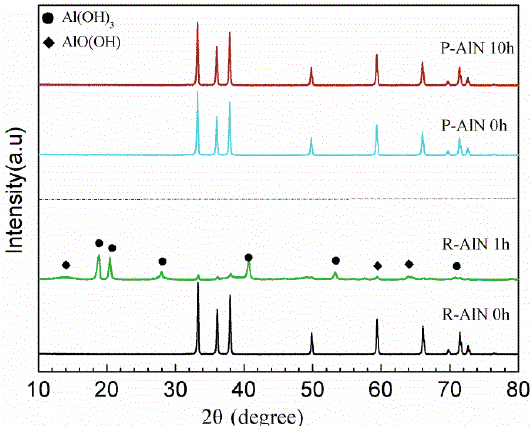
Figure 7. XRD spectrum of raw powder and modified powder under different hydrolysis resistance Times.